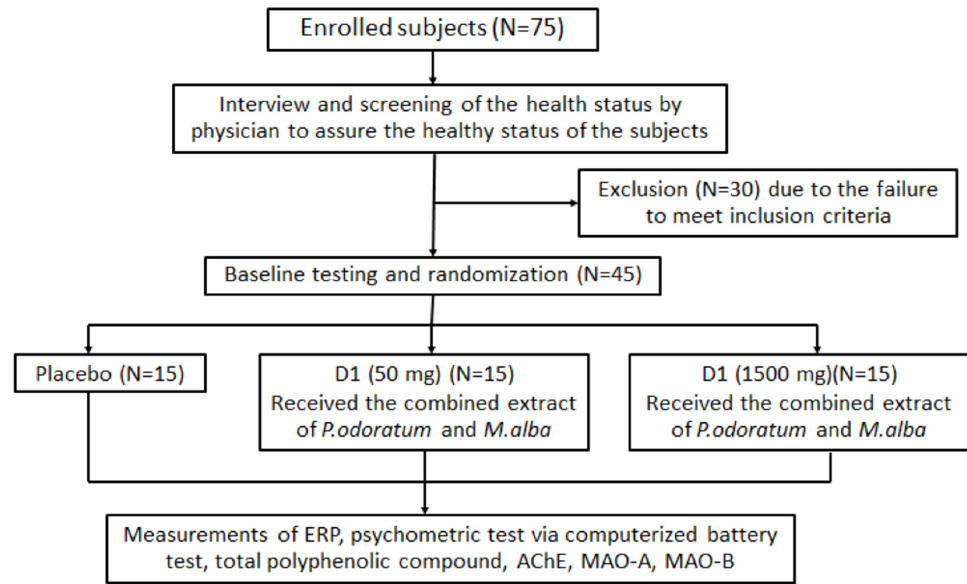
Figure 1. Schematic diagram illustrating experimental protocol.